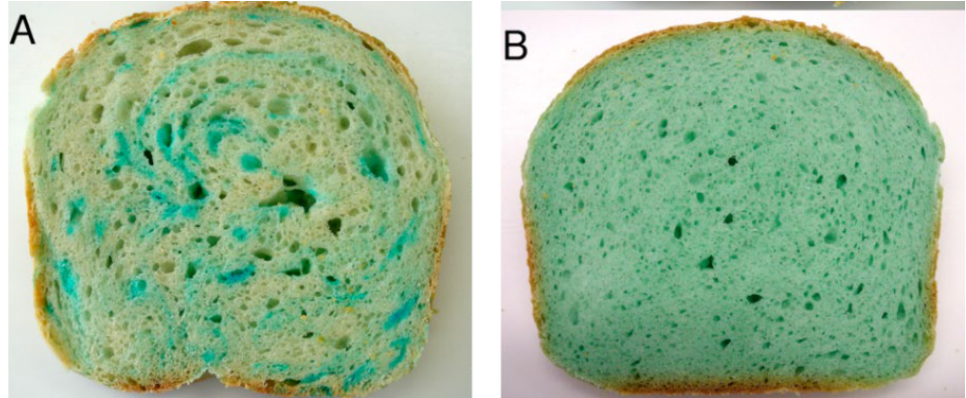
Figure 3. ( A ) Inhomogeneous sodium distribution of coarse-grained salt crystals ( 2−3.5 mm, 1.25% ) and ( B ) homogeneous sodium distribution of salt crystals (<2 mm, 1.5%) Adapted with permission from [79]. Copyright 2013 American Chemical Society.